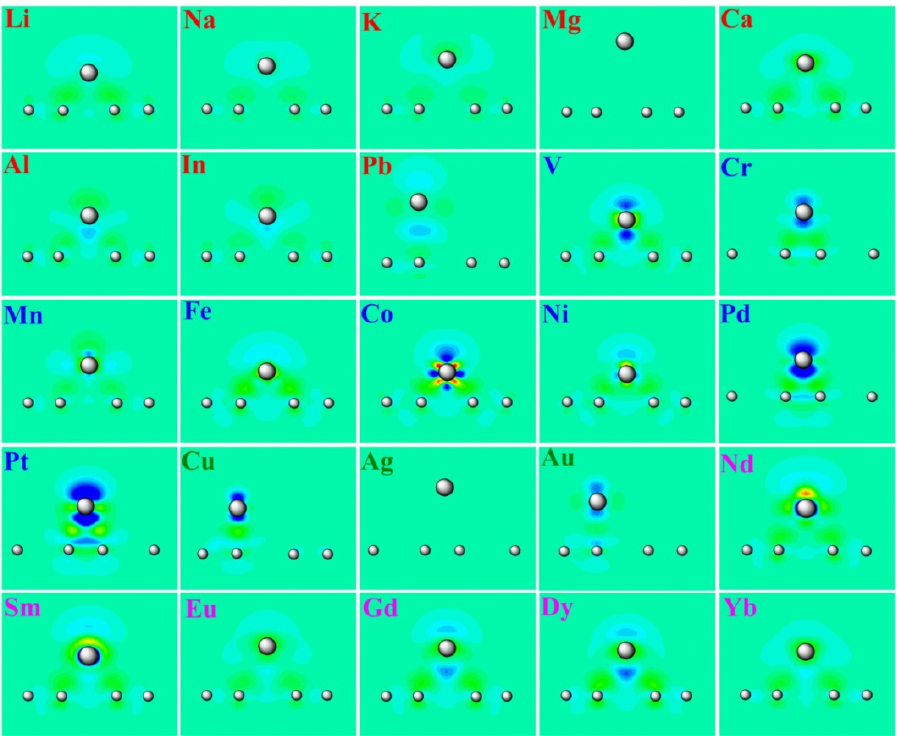
Figure 10. Bonding electron distributions (BED) in the vertical plane cutting through adatom and carbon atoms of the adatom/graphene system. Positive value (red color indicated 0.28 electron/Å 3 ) indicates an increase in electron density and negative value (blue color indicated − 0.14 electron/ Å 3 ) means an electron density loss with respect to the superposition of the atomic electron